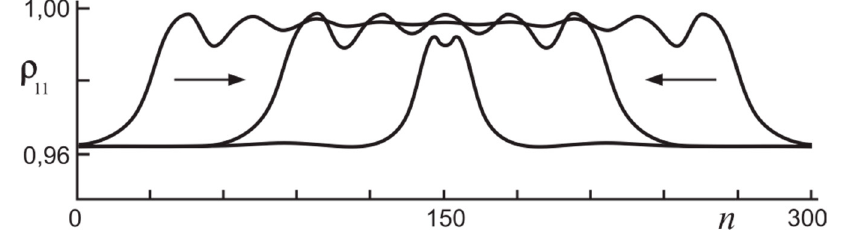
Figure 5. The dynamics of the ground state population in the regime of collision of a pair of counter-propagating switching waves. Arrows show the direction of fronts of switching waves propagation. Time moments t = 0 (the widest distribution), 120 and 440 (stable soliton, the narrowest distribution); N = 300, Ω = 0.95.